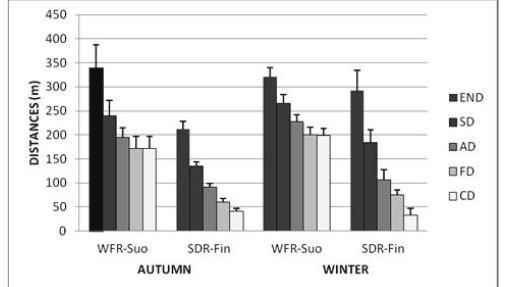
Fig. 4. Response distances (mean ± SD) of wild forest reindeer in Suomenselkä (WFR-Suo) and of semi-domestic reindeer in Finland (SDR-Fin) in groups disturbed by a directly approaching hu- man on foot/snowshoes during autumn and winter 2010-12. Sample sizes are: END (encounter), SD (sight) AD (alert), and FD (flight distance), n = 10 for WFR in autumn and n = 7 in winter, n = 17 for SDR-Fin in autumn and n = 6 in in winter, and CD (closest distance), n = 7 for WFR in autumn and n = 5 in winter, n = 14 for SDR-Fin in autumn and n = 4 in